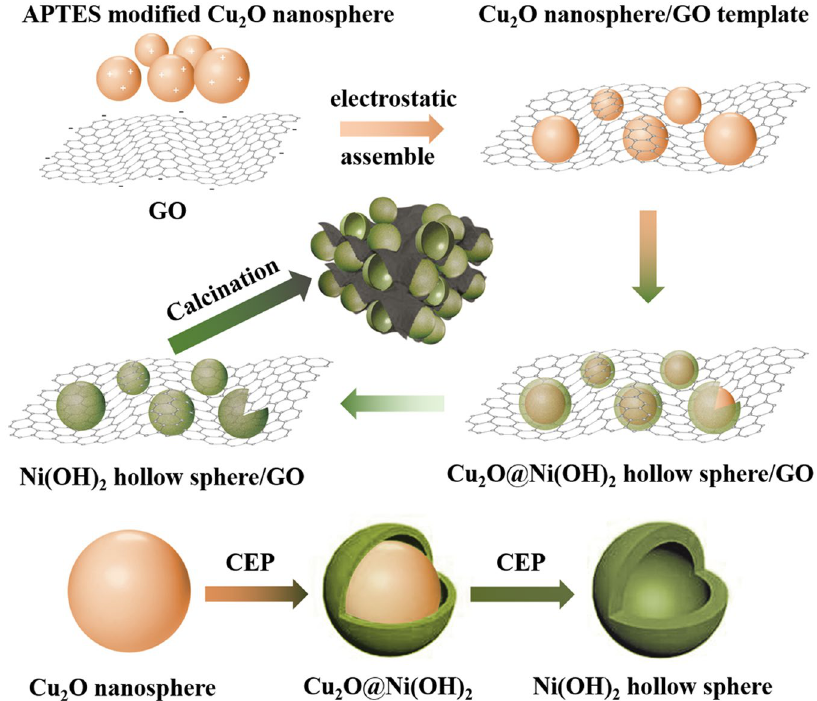
Figure 1. Schematic illustration of the synthesis procedure for 3D NiO hollow sphere/rGO composite. Abbreviations: CEP, coordinating etching and